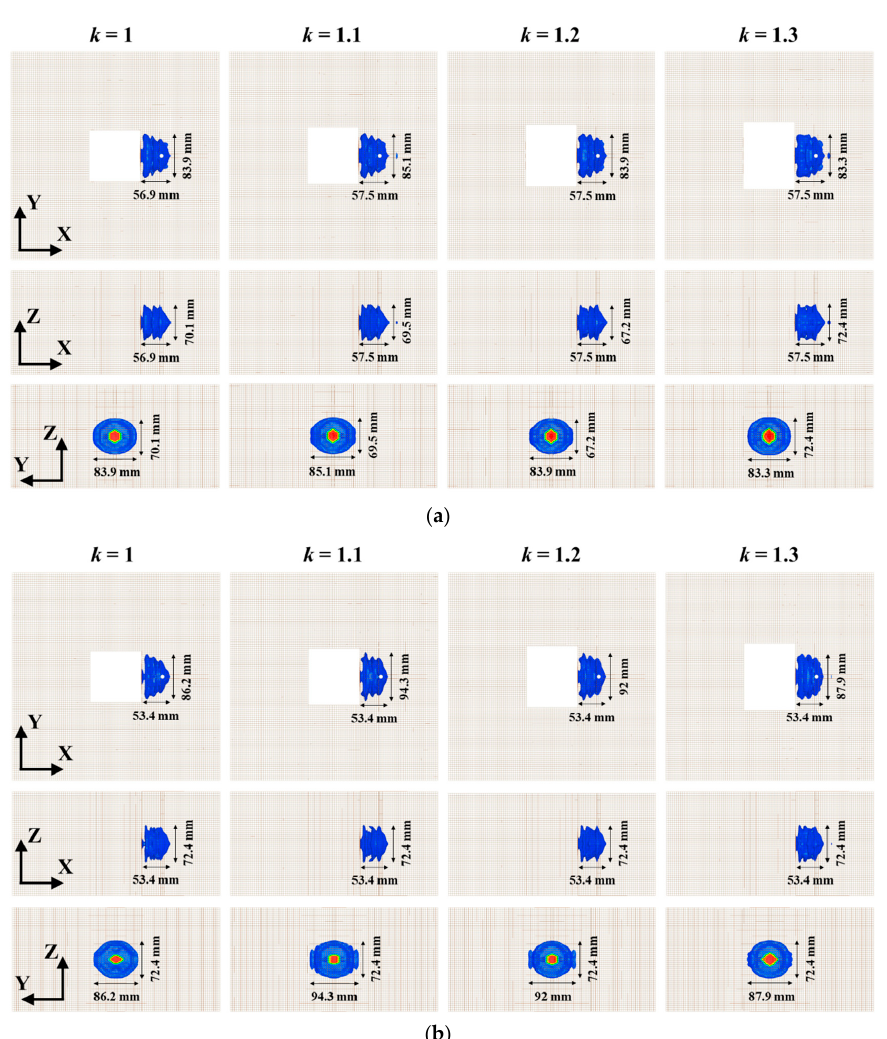
Figure 13. The explosion crater with different k : ( a ) P1 = P2 = 5 MPa; ( b ) P1 = 5 MPa; P2 = 10 MPa.